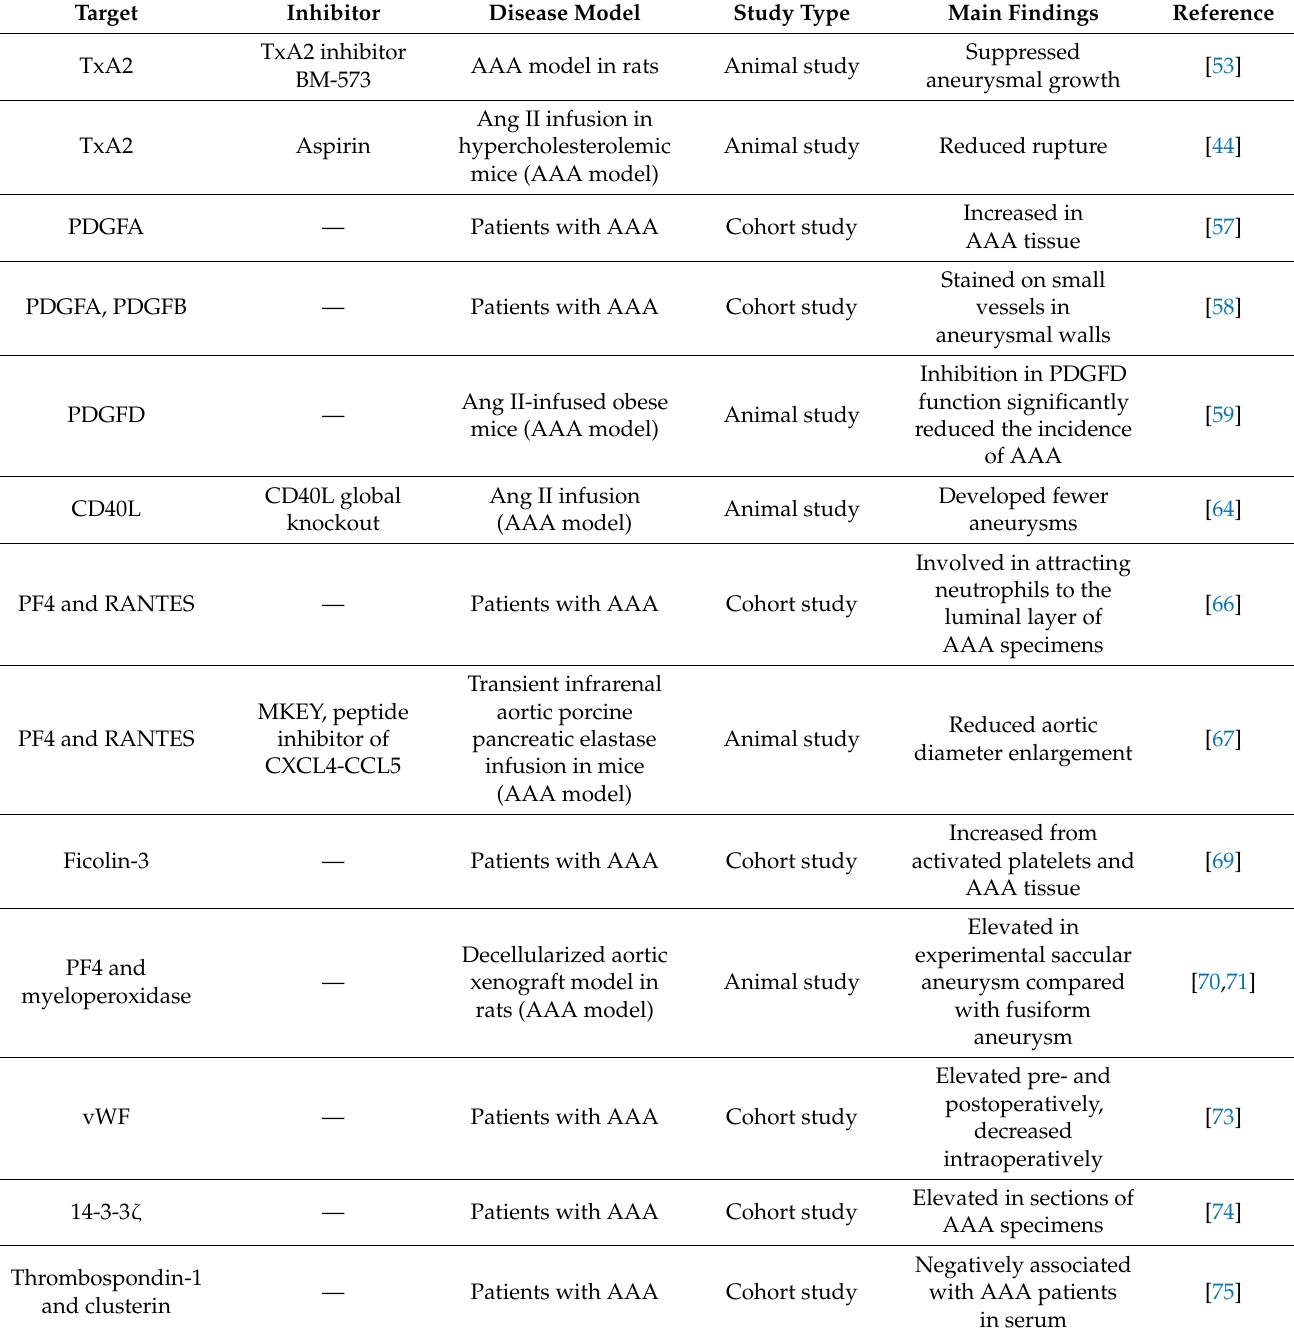
Table 2. Characteristics of studies of platelet-derived mediators in